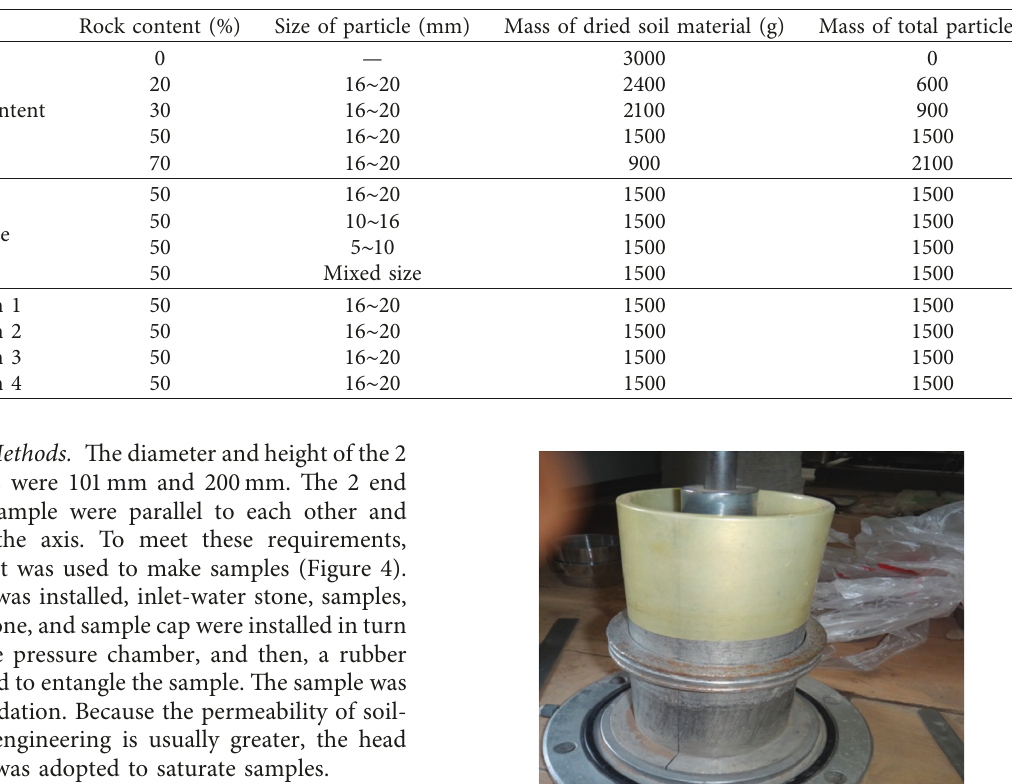
Table 3: Test design of soil-rock mixtures.